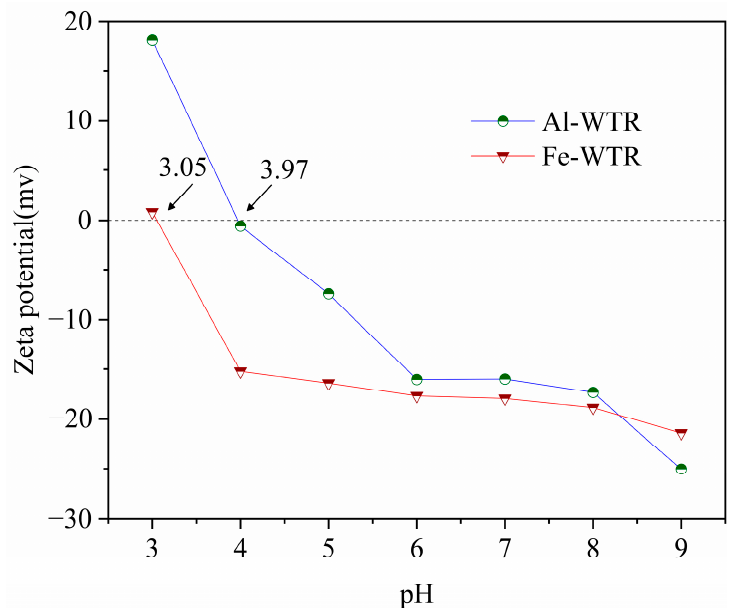
Figure 4. Zeta potential diagram of Fe-WTR and Al-WTR.